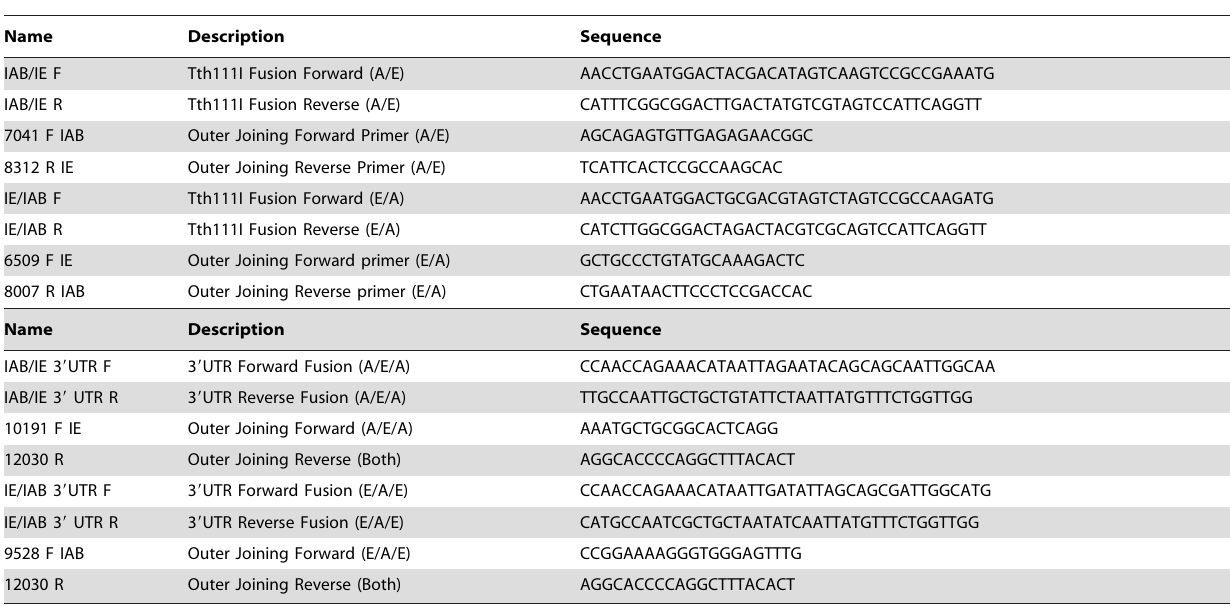
Table 1. Primers used to generate